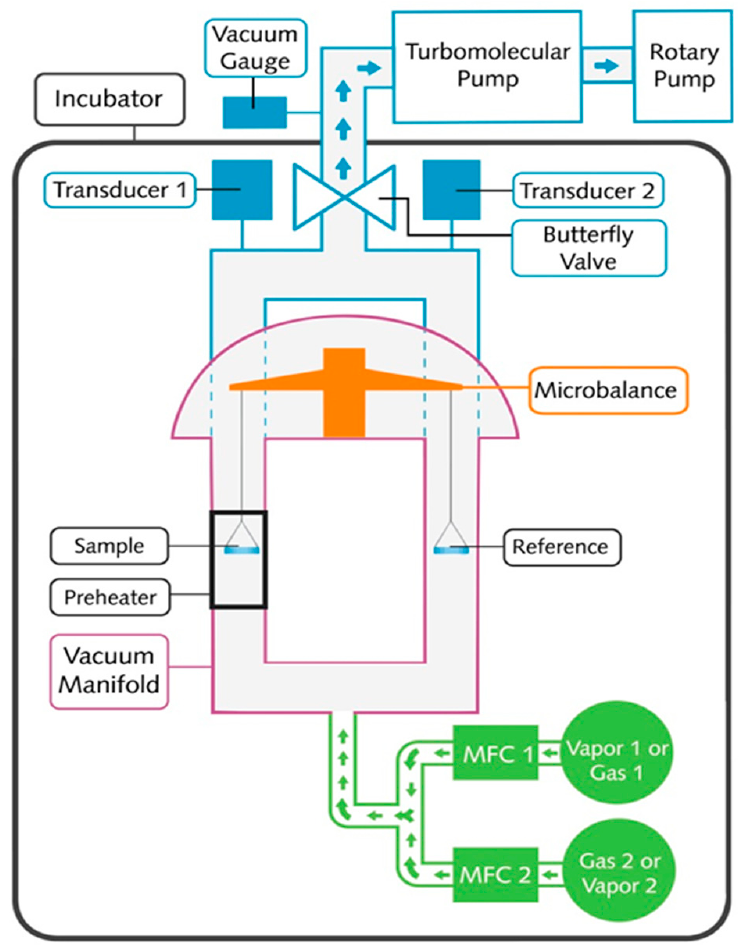
Figure 5. Schematic of DVS vacuum.